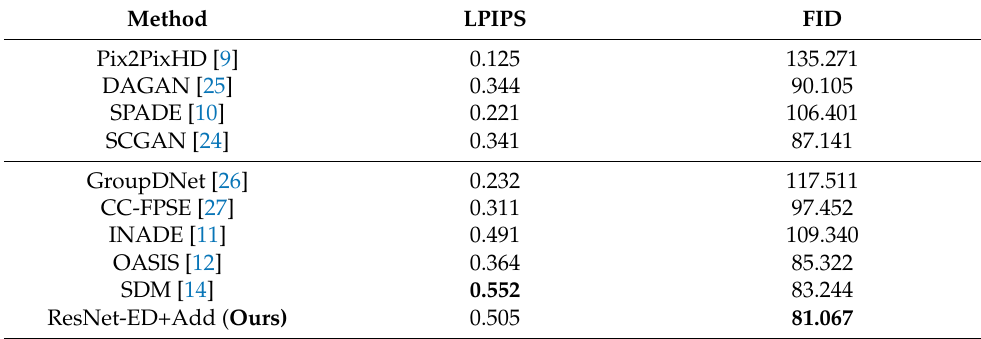
Table 4. Comparison between the proposed ResNet-ED and SOTA methods on the ADE20K Indoor subset in terms of LPIPS and FID metrics. Note that all other methods are trained on the whole ADE20k dataset, while ours is only trained on the ADEK20 Indoor subset. Note that the best values in terms of LPIPS and FID are